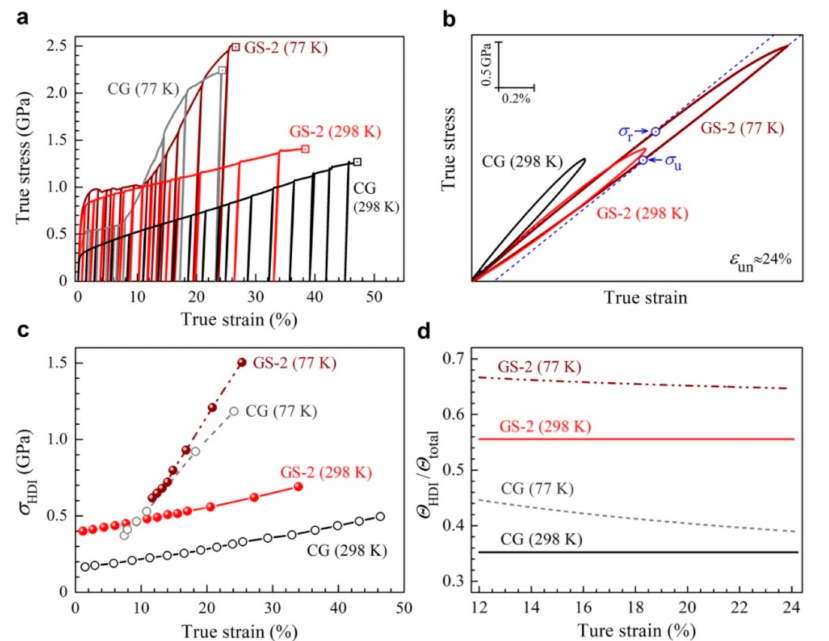
Figure 4. HDI hardening in the CG and GS2 samples at both room and cryogenic temperatures. ( a ) The true stress–strain curves for LUR tests. ( b ) The typical hysteresis loops at an unloading strain of 24%. ( c ) The curves of the HDI stress as a function of the true strain. ( d ) The curves of the Θ Θ HDI / total as a function of the true